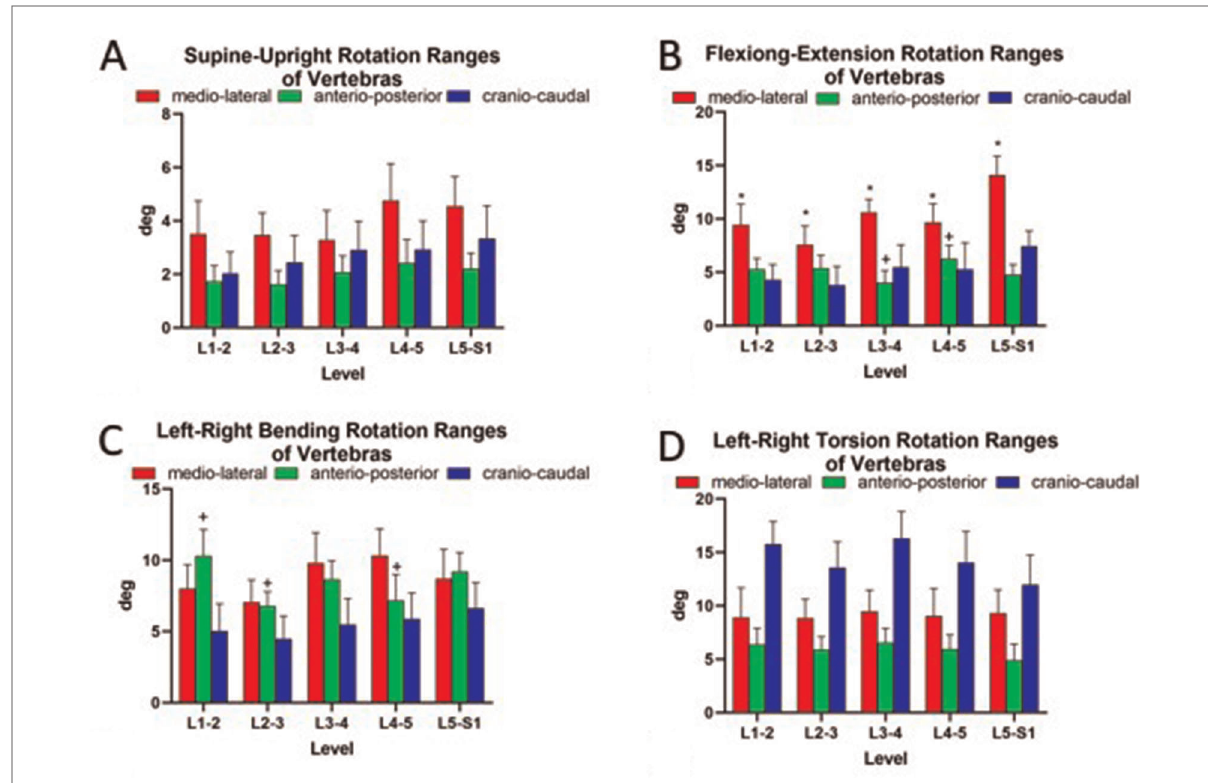
FIGURE 4 Ranges of vertebral rotations of asymptotic volunteers ( A ) standing up and along three principal axes under ( B ) fl exion – extension, ( C ) bending, and ( D ) torsion of the trunk. The symbols (*, +, x, #, − ) represent statistical signi fi cance on between-level comparison ( P